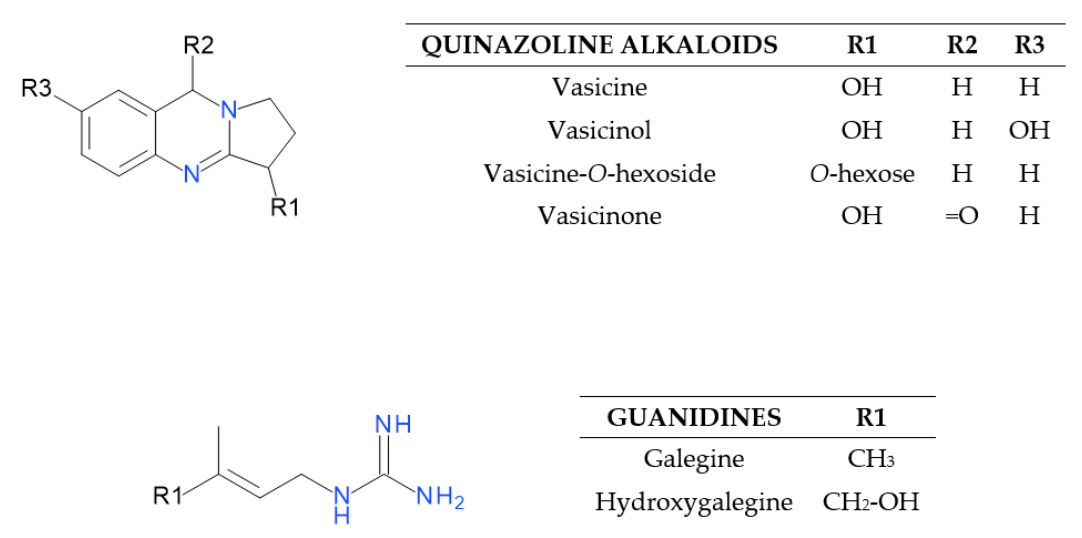
Figure 1. Structures of quinazoline alkaloids and guanidines identified in the G. officinalis herb.